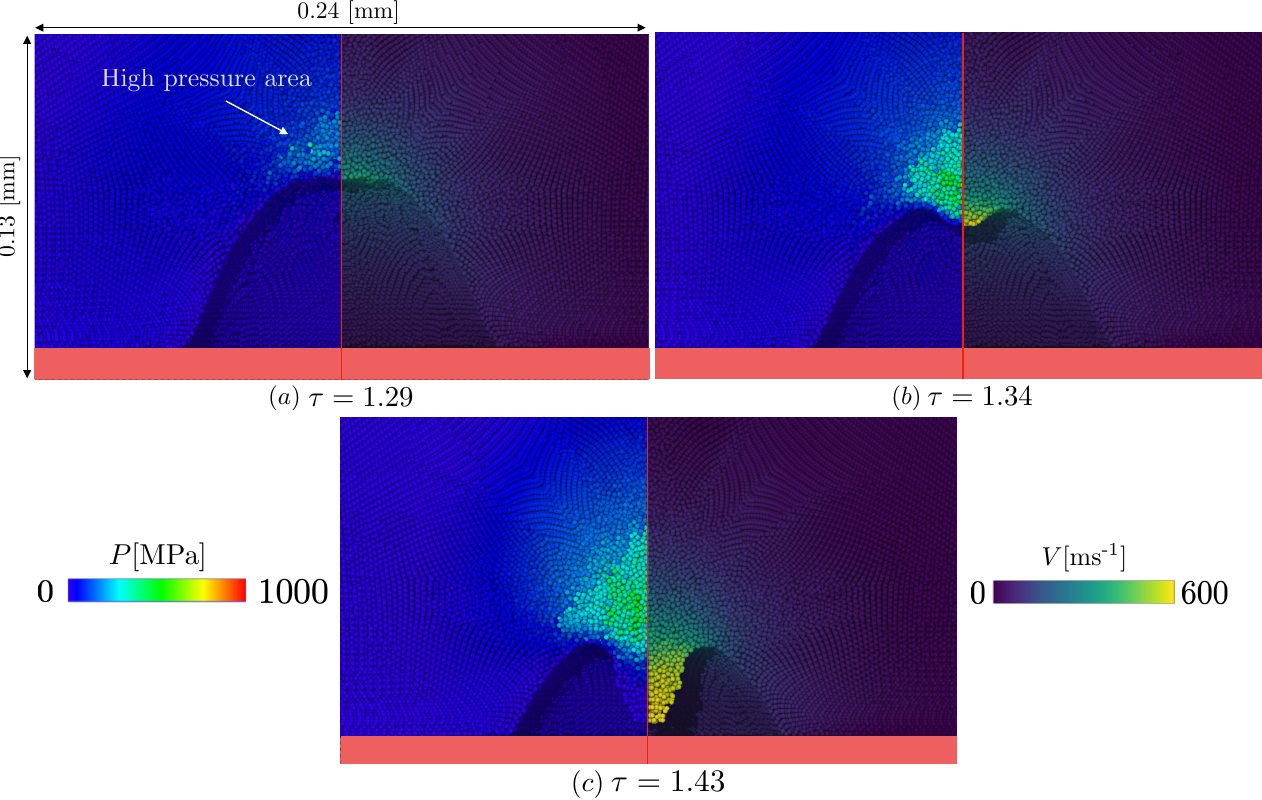
Figure 4. Pressure and velocity field in the domain represented in Figure 1 for different collapse snapshots in Region I ( dL / R 0 = 133, γ = 0.6 & P ∞ = 50 [MPa]): ( a ) Anisotropic pressure field formation in the liquid phase ( b ) Generation of the jet towards the surface. ( c ) High-speed/Low pressure profile of the fully-developed